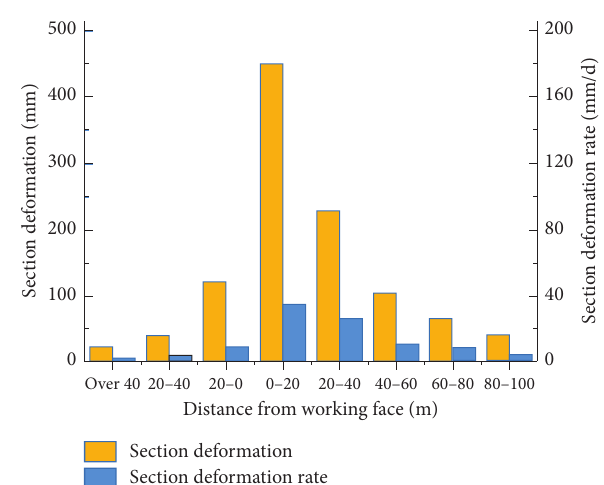
Figure 13: Deformation data statistics of surrounding rock of roadway